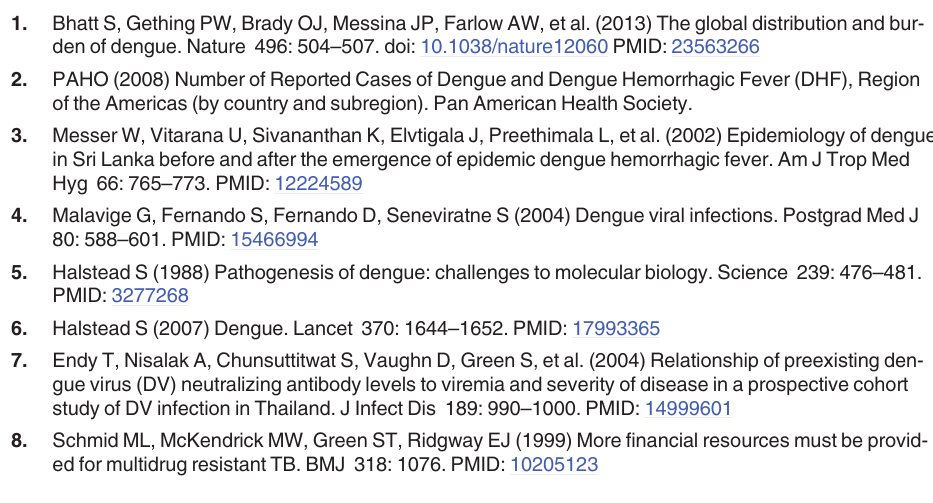
S1 Fig. Analytical strategy to assess the activation of naïve and memory CD8+ T cells. A gate on single cells was determined by the size in relation to height (FSC-H) and relative area (FSC-A). Then a gate was made in the total lymphocyte population followed by a gate on the CD3+ population. Thereafter, two other gates were made in populations of T lymphocytes (CD4+ and CD8+). Within the population of CD8+ T lymphocyte subpopulations were evalu- ated naïve and memory from the Boolean analysis, which was made all possible combinations with the markers CCR7, CD45RA, CD27. Within each population (naïve, TCM, TEM and TEMRA) a quadrant gate was carried out to evaluate the expression of activation markers HLA-DR and CD38. S2 Fig. Analytical strategy to assess the expression of Ki67 in CD8+ T cells. A gate on single cells was determined using forward scatter height (FSC-H) and relative area (FSC-A). The lym- phocyte population was delimited followed by a gate on CD3+ cells. CD8+ T cells were identi- fied within the CD3+ T cells and analyzed for Ki67